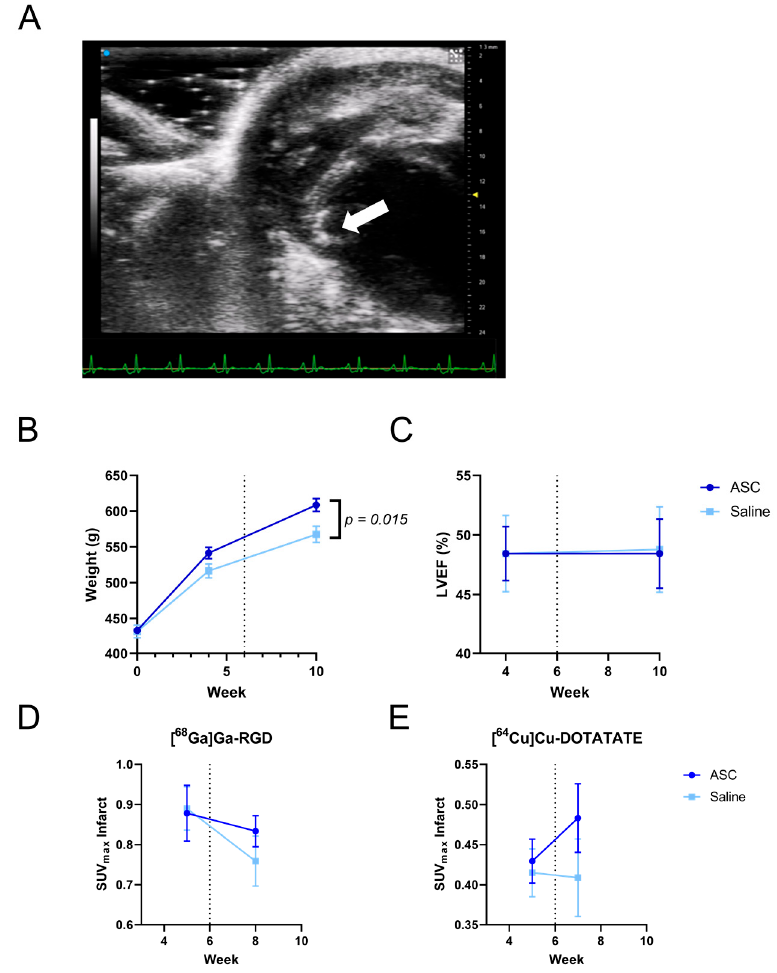
Figure 3. Treatment effect of ASCs. Trans-thoracic intra-myocardial injection ( A ). The needle is visible outside the chest, and the injected fluid can be seen as small white bubbles in the myocardium (arrow). There was a significant difference in the weight of the animals between groups ( B ) but no significant effect on LVEF ( C ) or uptake of [ 68 Ga]Ga-RGD ( D ) and [ 64 Cu]Cu-DOTATATE ( E ), n = 27. LVEF; left ventricular ejection